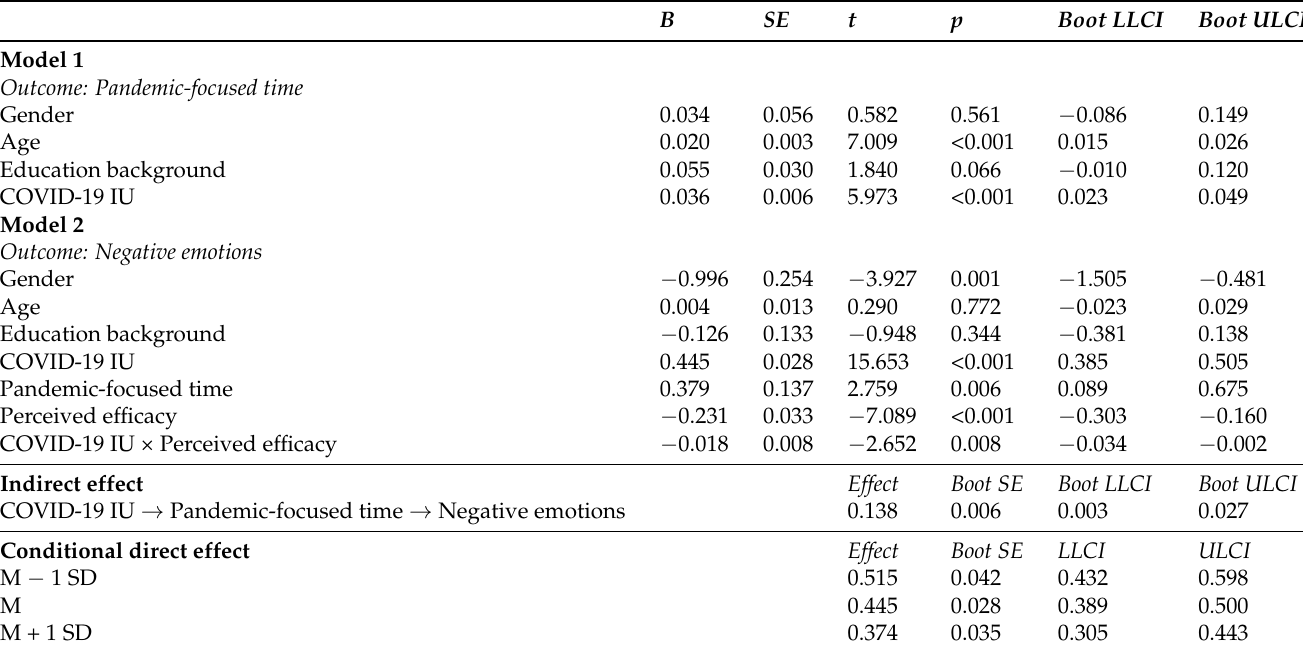
Table 3. Mediation analysis and conditional process